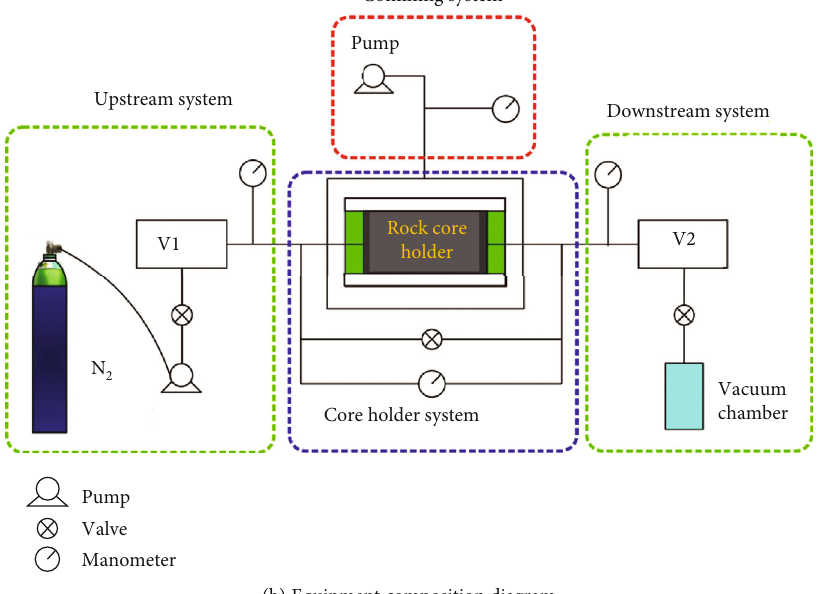
Figure 3: The measurement